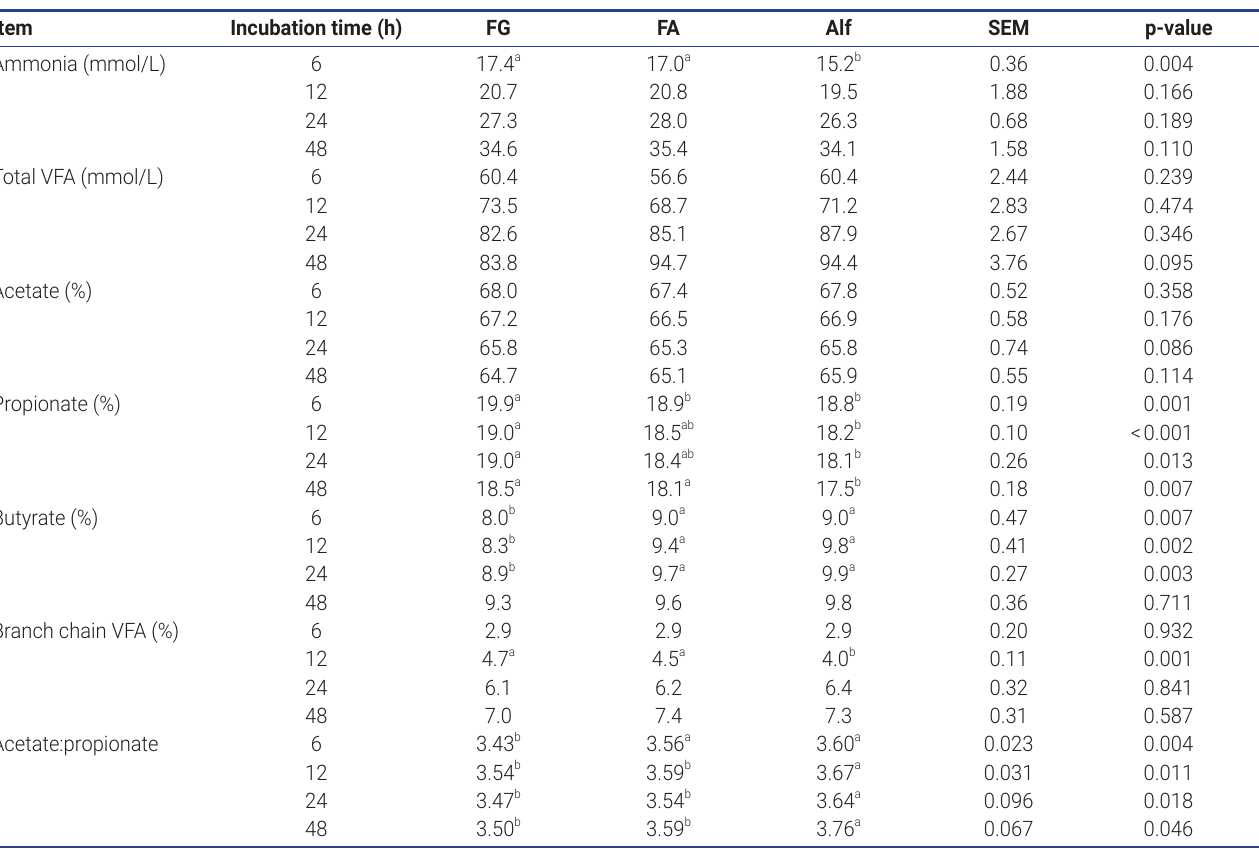
Table 5. Ammonia concentration and profile of volatile fatty acids (VFA) in liquid fraction of whole culture of in vitro ruminal incubation of forages in the early